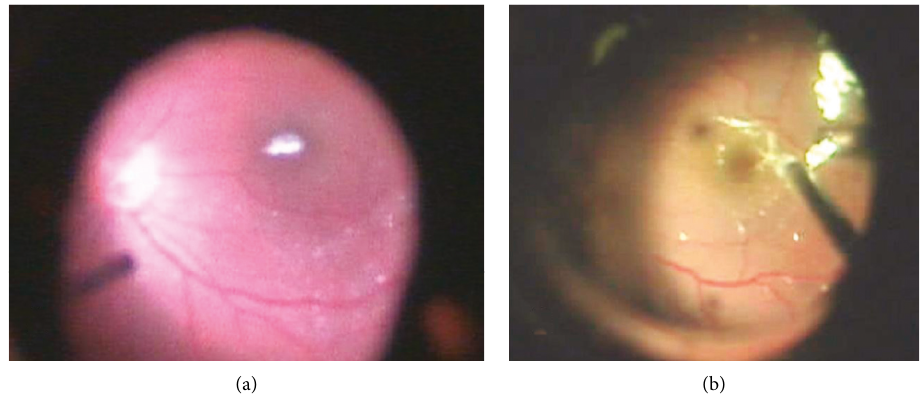
Figure 2: Patterns of the residual vitreous cortex (RVC): (a) focal type; (b) diffuse